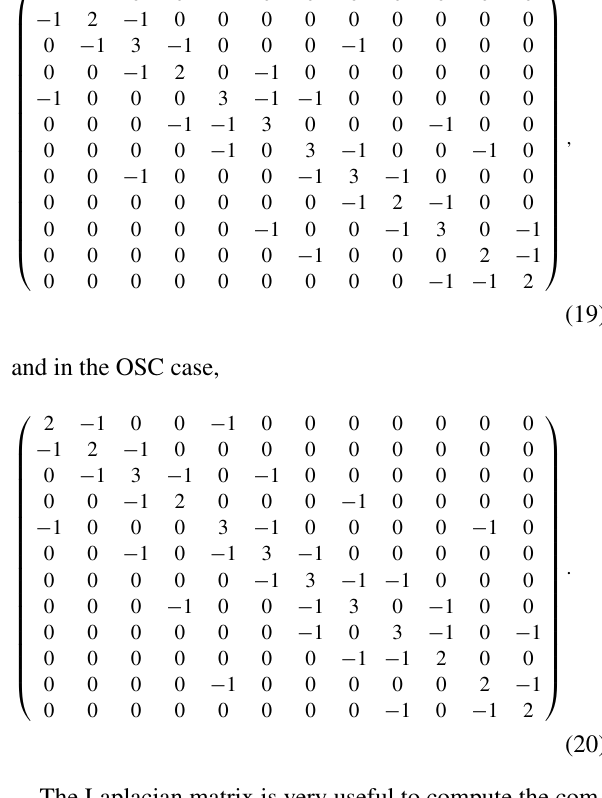
Fig. 7 Multiplicity plot for q = 31 GeV in the open spin chain